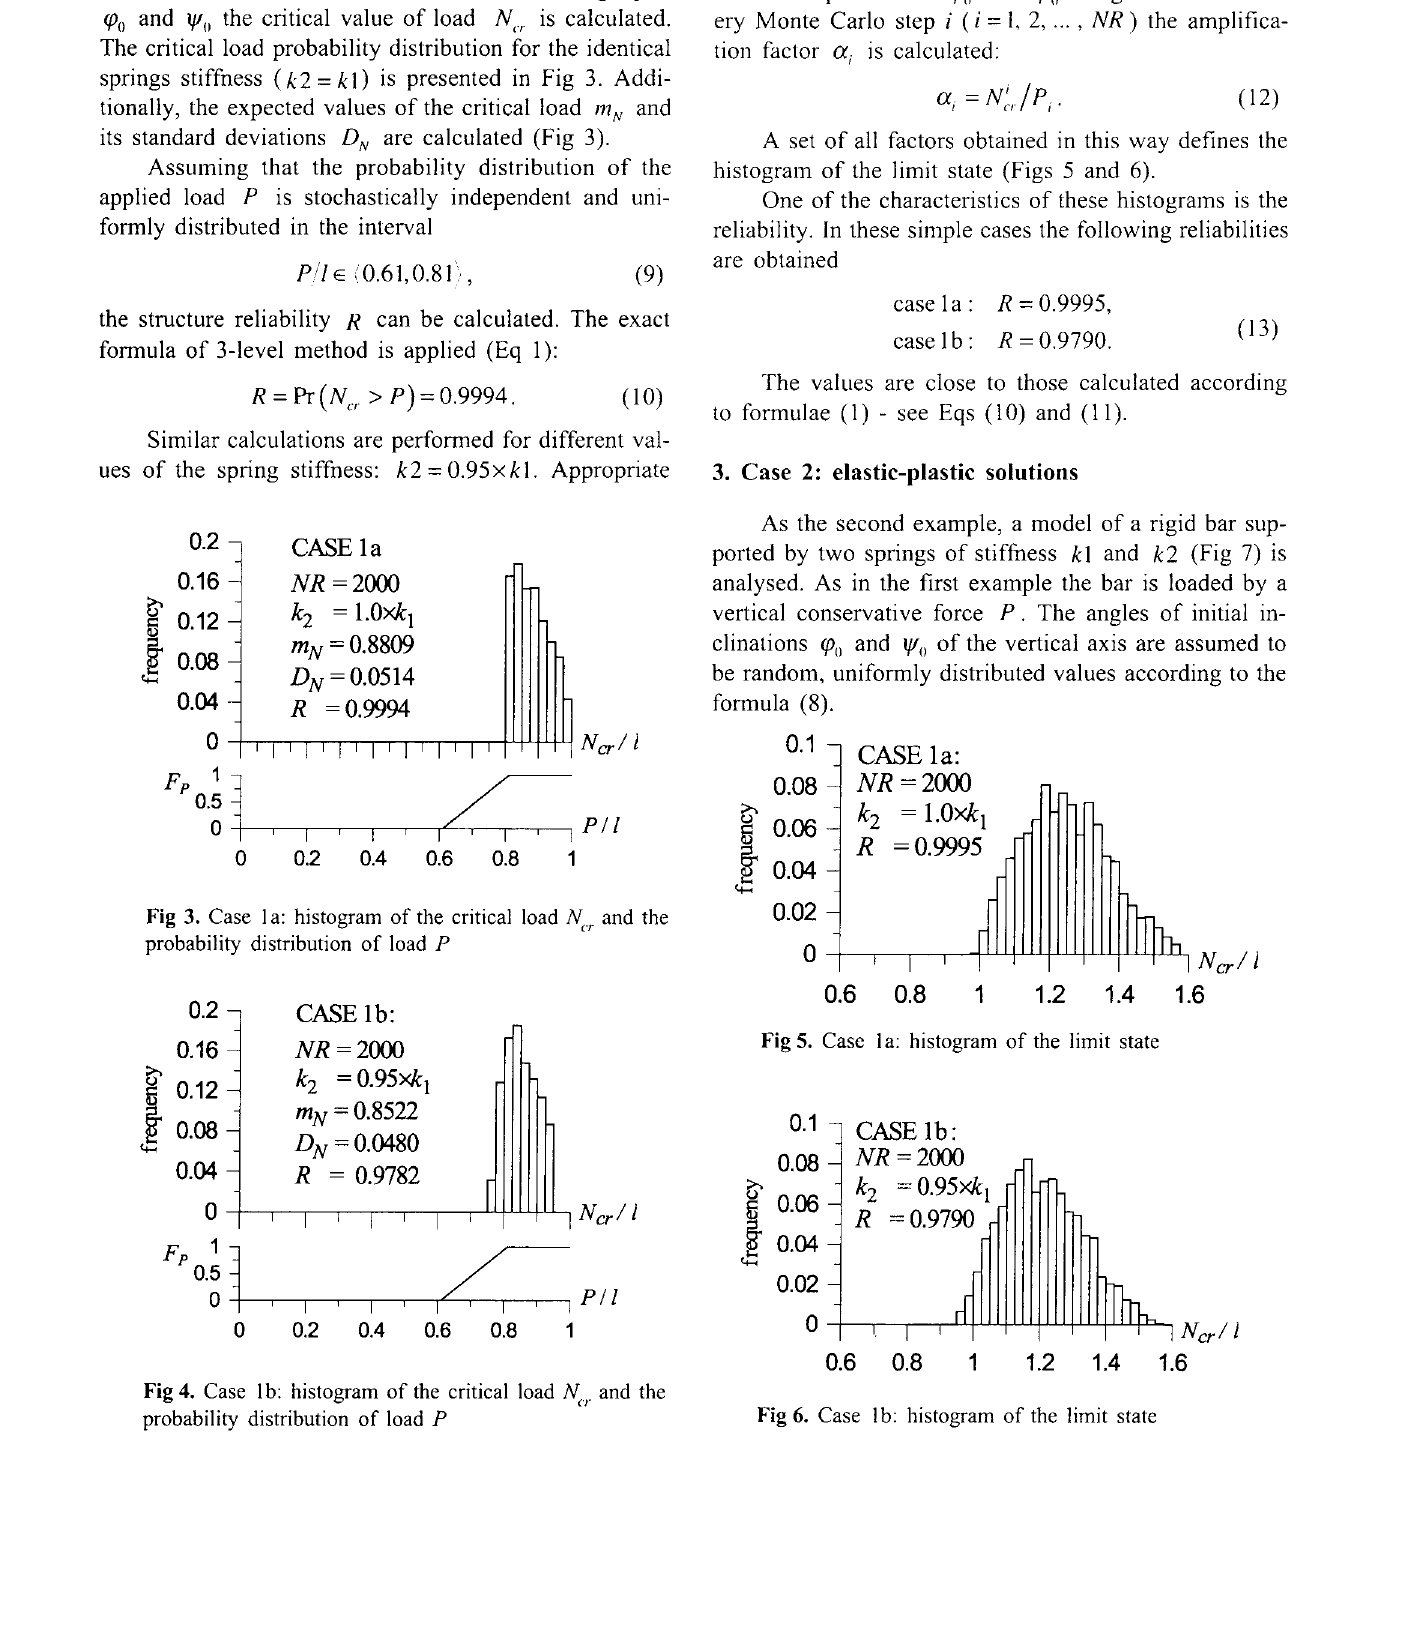
Fig 6. Case I b: histogram of the limit